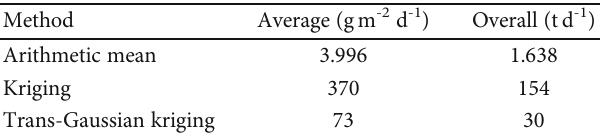
Figure 5: Quanti fi ed CO Table 4: Averages and totals for the whole area through di ff erent methods.